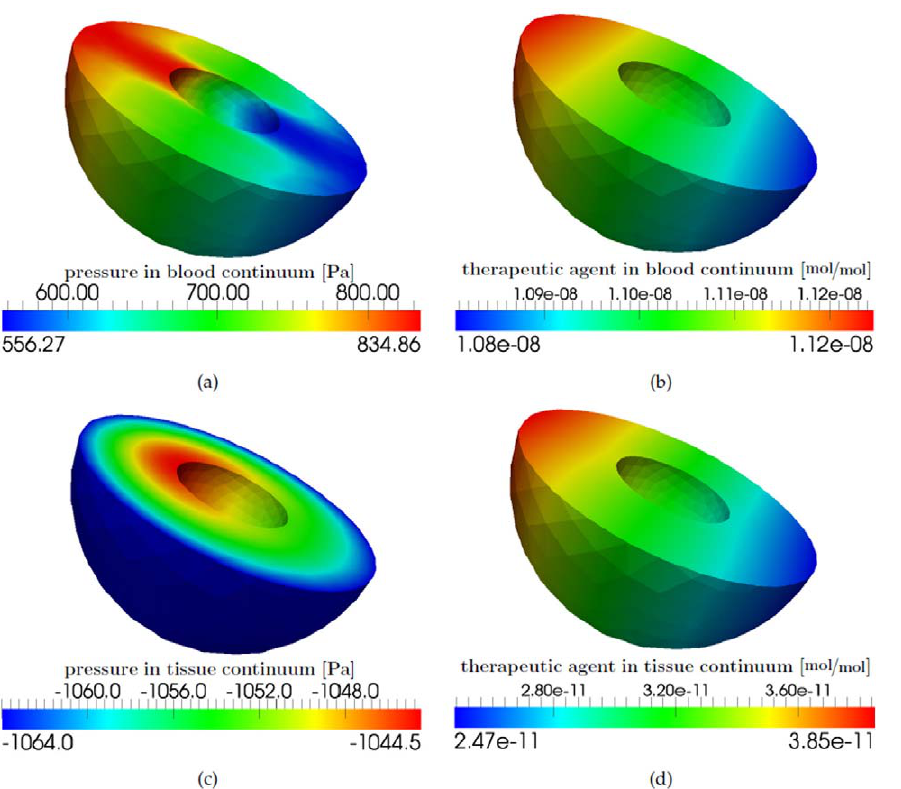
Figure 13. Results for a healthy alveolus (leftmost red node in Figure 10), at the final time step of the simulation. (a) Pressure distribution within the pulmonary capillary bed continuum [Pa]. (b) Drug distribution [ mol = mol ] within the pulmonary capillary bed continuum. (c) Pressure distribution within the pulmonary tissue continuum [Pa]. (d) Drug distribution [ mol = mol ] within the pulmonary tissue continuum.